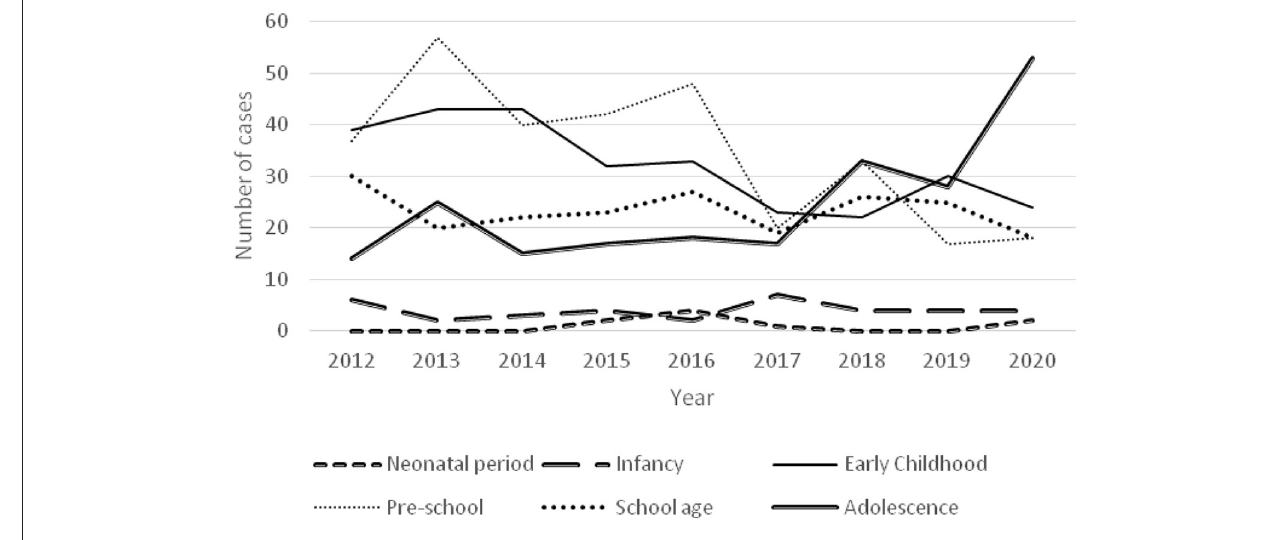
FIGURE 3 | Time-varying curve of the number of children in each age group.